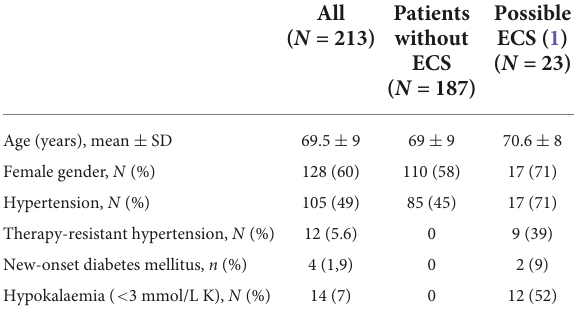
All Patients ( N = 213) without